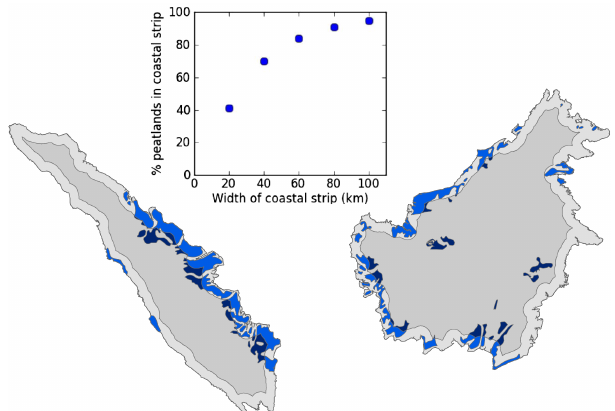
Figure 6. Distribution of peatlands along the coastlines of Sumatra and Borneo as of FAO (2009). The light-grey area refers to a 40km wide coastal